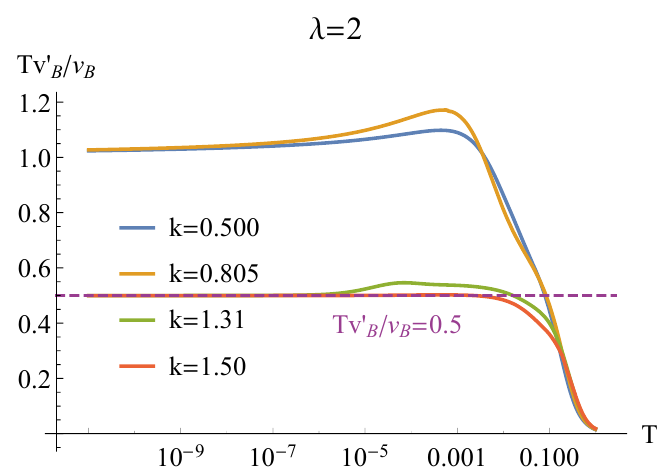
Figure 4 . Tv 0 =v B v.s. T for di(cid:11)erent phases ( k = 0 : 500 ; 0 : 805 corresponds to metallic phases and B k = 1 : 31 ; 1 : 50 corresponds to insulating phases). The purple dashed line points to Tv 0